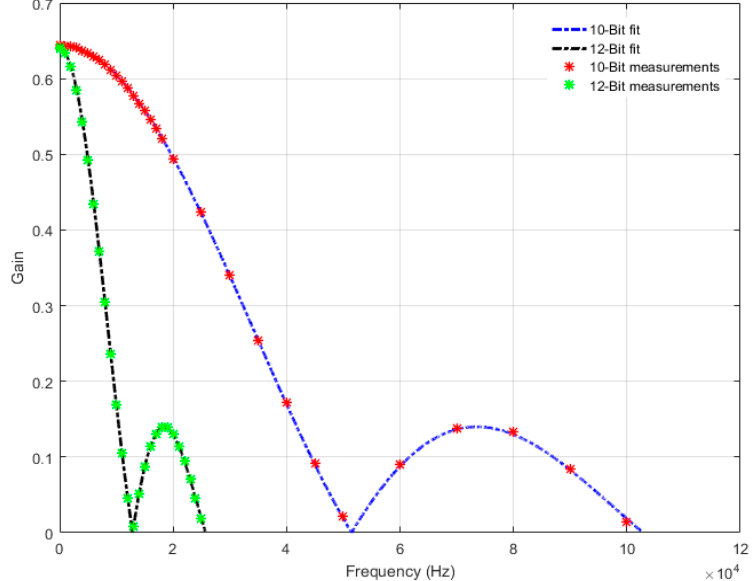
Σ∆ -ADC gain response. Figure 15. ΣΔ -ADC gain response. Figure 15.